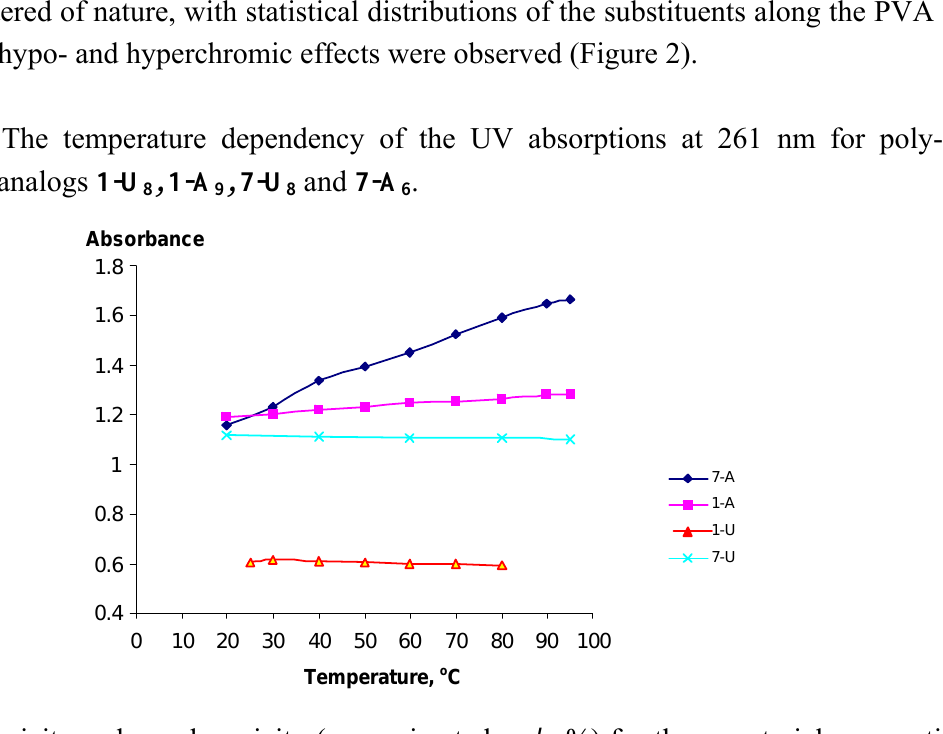
Figure 2 . The temperature dependency of the UV absorptions at 261 nm for poly- nucleotide analogs 1-U